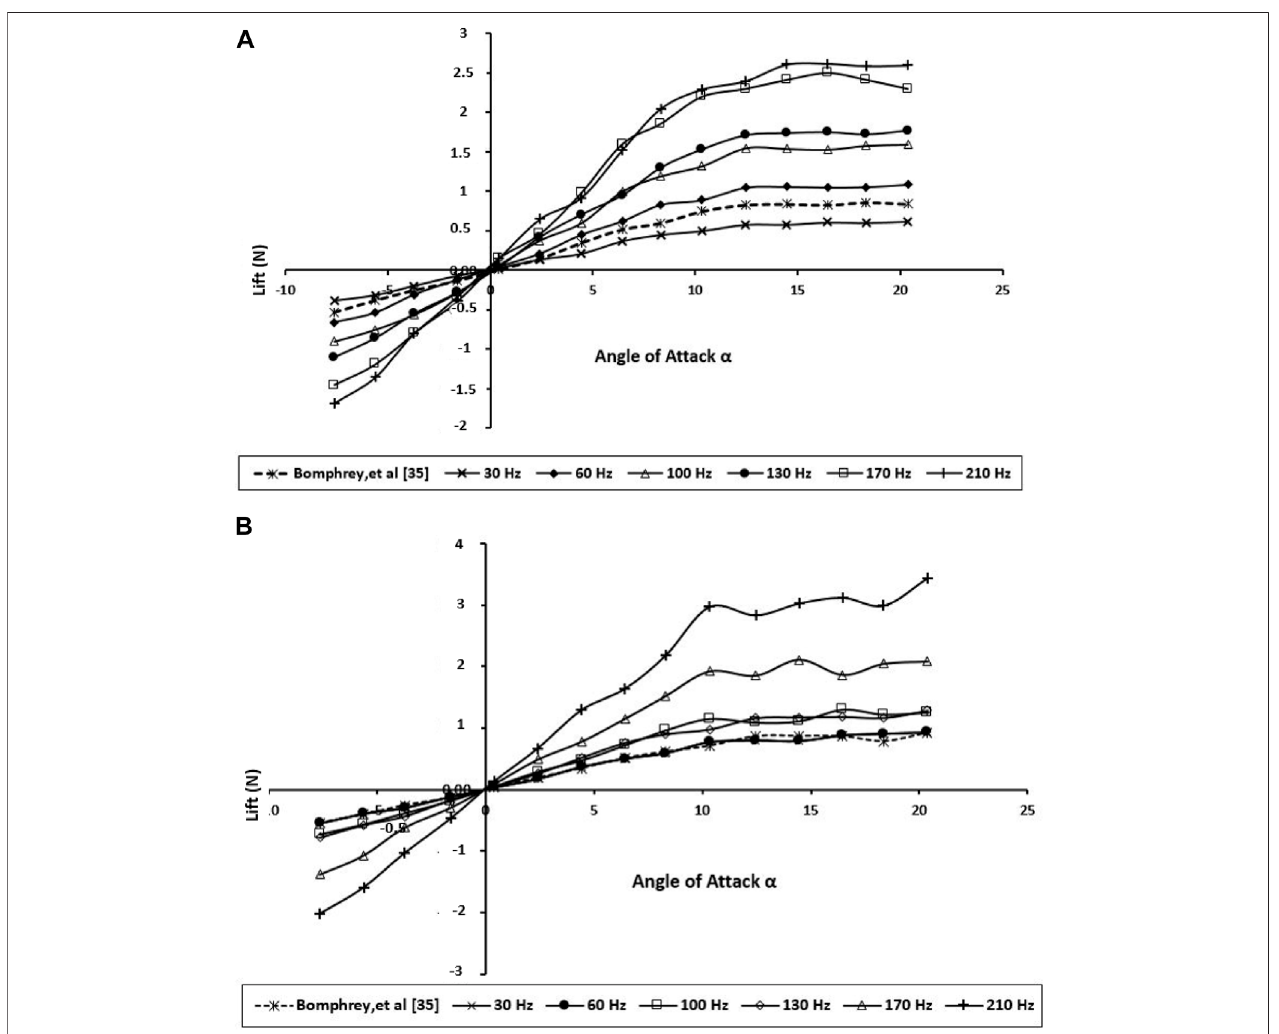
FIGURE 8 | Generated lift for the BMAV ’ s wing at various angles of attack and wing beat frequencies; (A) forewing; (B) hindwing.